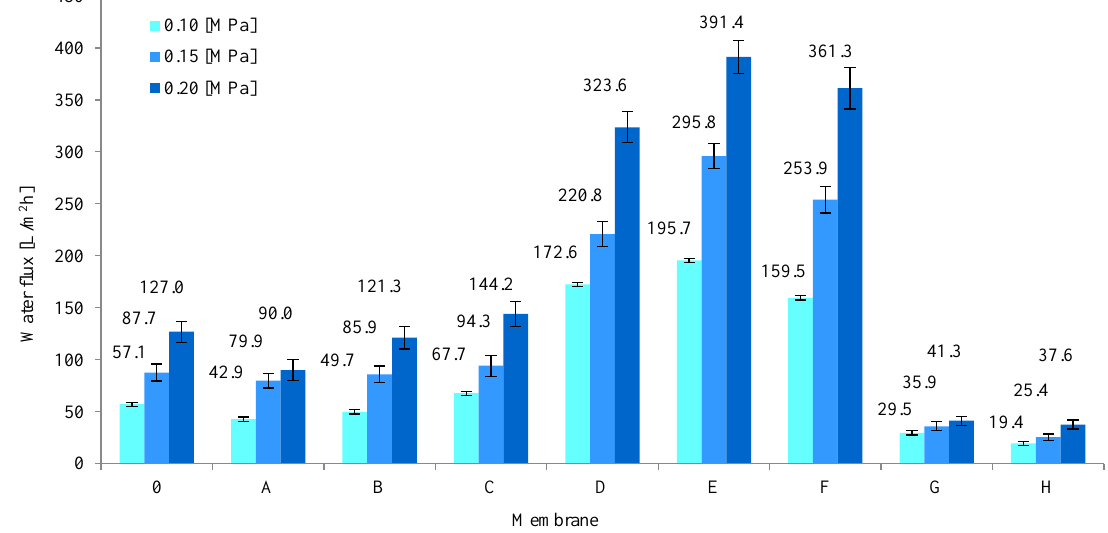
Figure 4. Values of volumetric permeate flux for membranes made from pure PAN (membrane 0) and composite rGO / PAN membranes (membranes A–H).